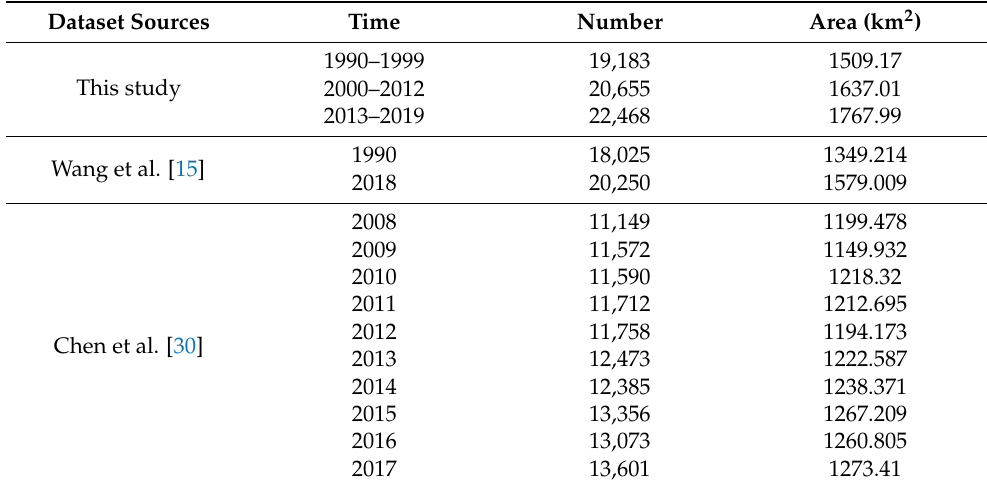
Table 2. Number and area of glacial lakes in different datasets within the TP